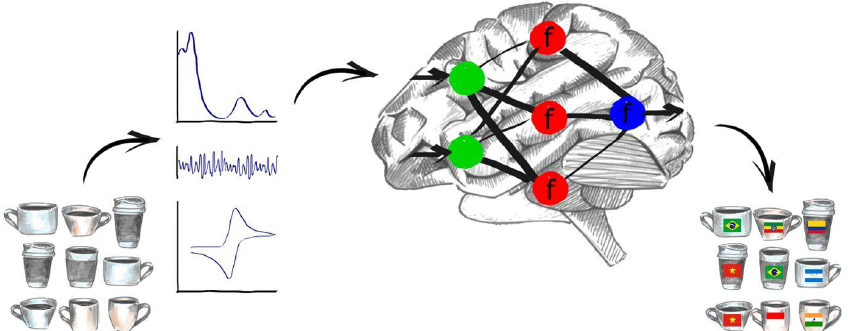
Figure 1. Working principle of an electronic tongue system: Physical, chemical and biochemical properties of the samples are measured by means of an array of sensors, which translate those specific attributes to an analytical signal (optical, electrophysiological, electrochemical etc.). So obtained data are then analysed by means of chemometric techniques or neural networks, which provide final information about the sample—for example discriminate coffee samples by their geographical origin.